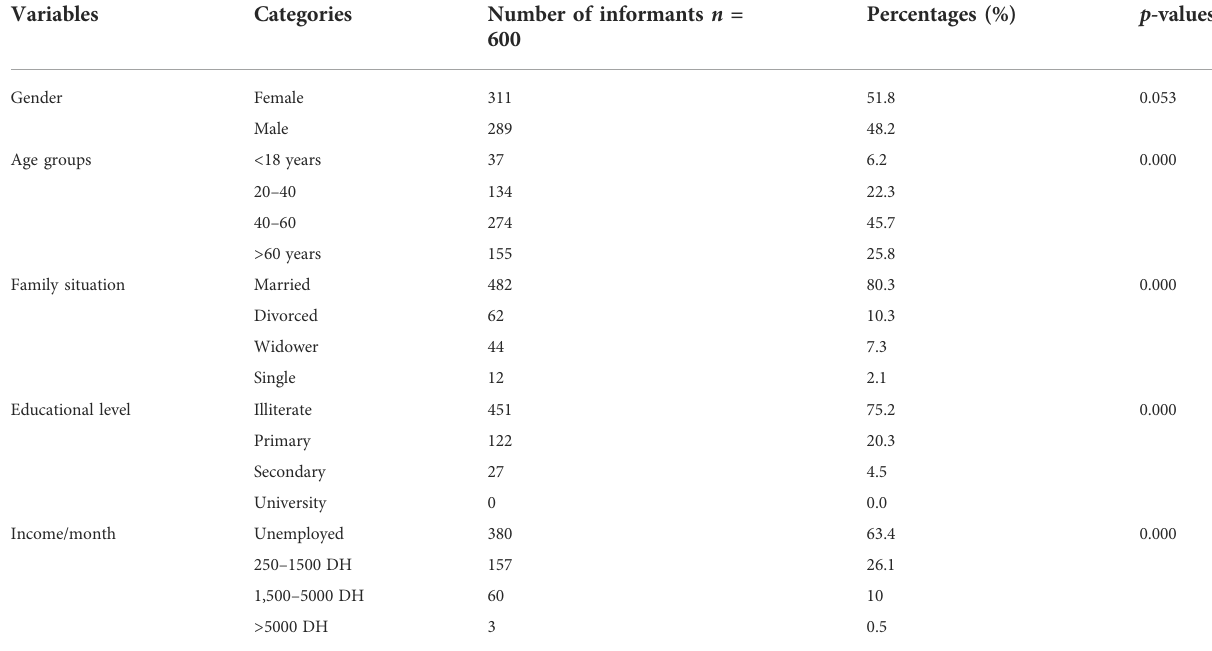
TABLE 1 Sociodemographic details of the informants in the Moroccan Rif